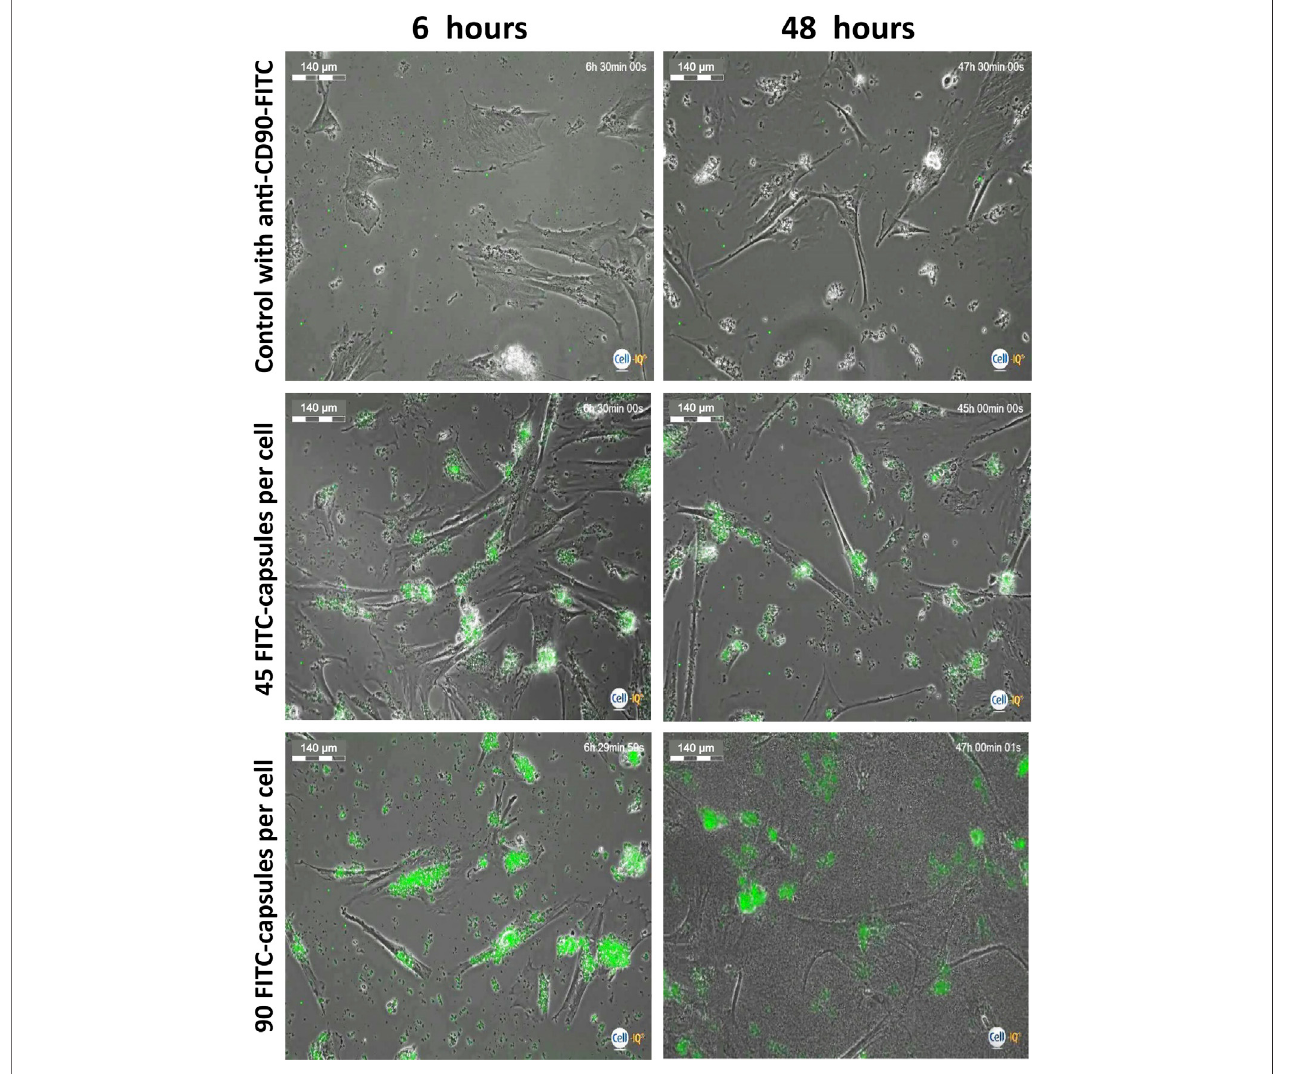
FIGURE 3 | Evaluation of microcapsule internalization on cell morphology. Isolated human MSCs were incubated with FITC-labeled capsules at a ratio of 1:0 (control),1:45, and1:90 microcapsules per cellfor24 hat37 ° C,thenthecellswerewashedwithPBS, collected,transferredtoanother plate,and furthercultured forup to 48 h. At 6 and 48 h post-phagocytosis, cells were analyzed using the Cell-IQ v2MLF integrated platform for a continuous real-time phase-contrast imaging as described in the Methods. There is minimal change in cell morphology or death rate when capsules are used at a 1:45 ratio, relative to control, although signi fi cant microcapsule uptake is observed. However, at a ratio of 1:90, cell shrinkage is apparent. Scale bar is 140 microns.